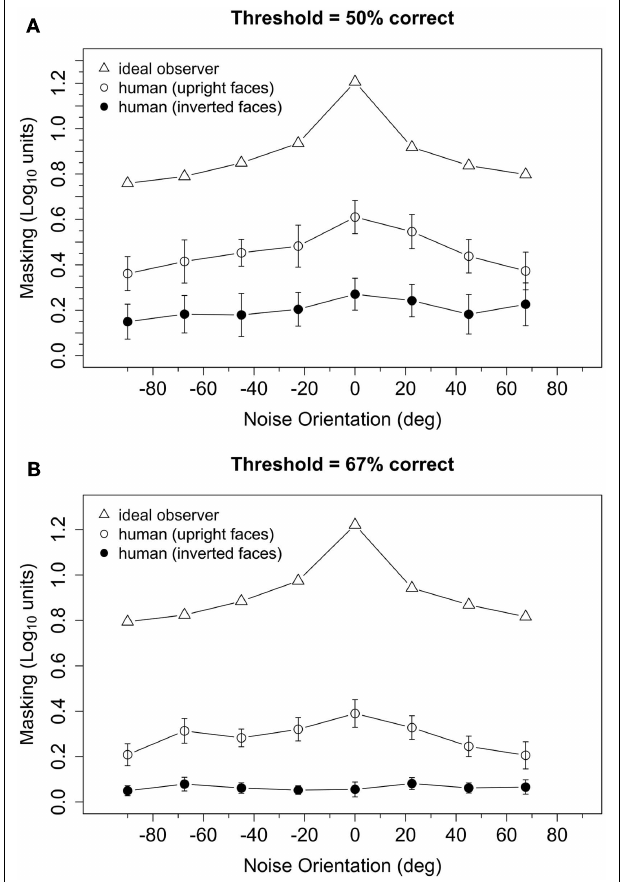
FIGURE 3 | Log-transformed masking ratios plotted as a function of noise orientation for the ideal observer and human observers with upright and inverted face stimuli. Threshold was defined as the RMS contrast needed to achieve 50% (A) or 67% (B) correct responses, and the masking ratio was defined as the mean of the log-transformed ratios of masked to unmasked contrast thresholds. Error bars represent ± 1